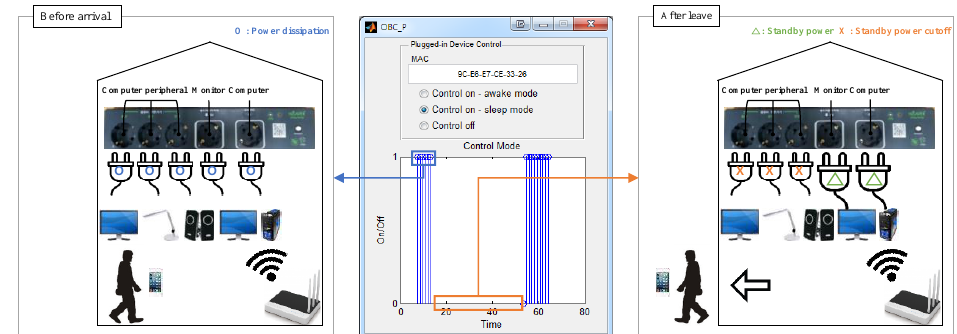
Figure 11. Awake mode algorithm.